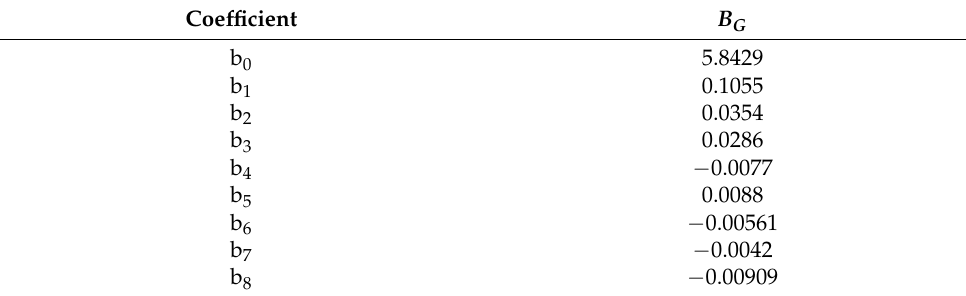
Table 7. The components of the vector B G